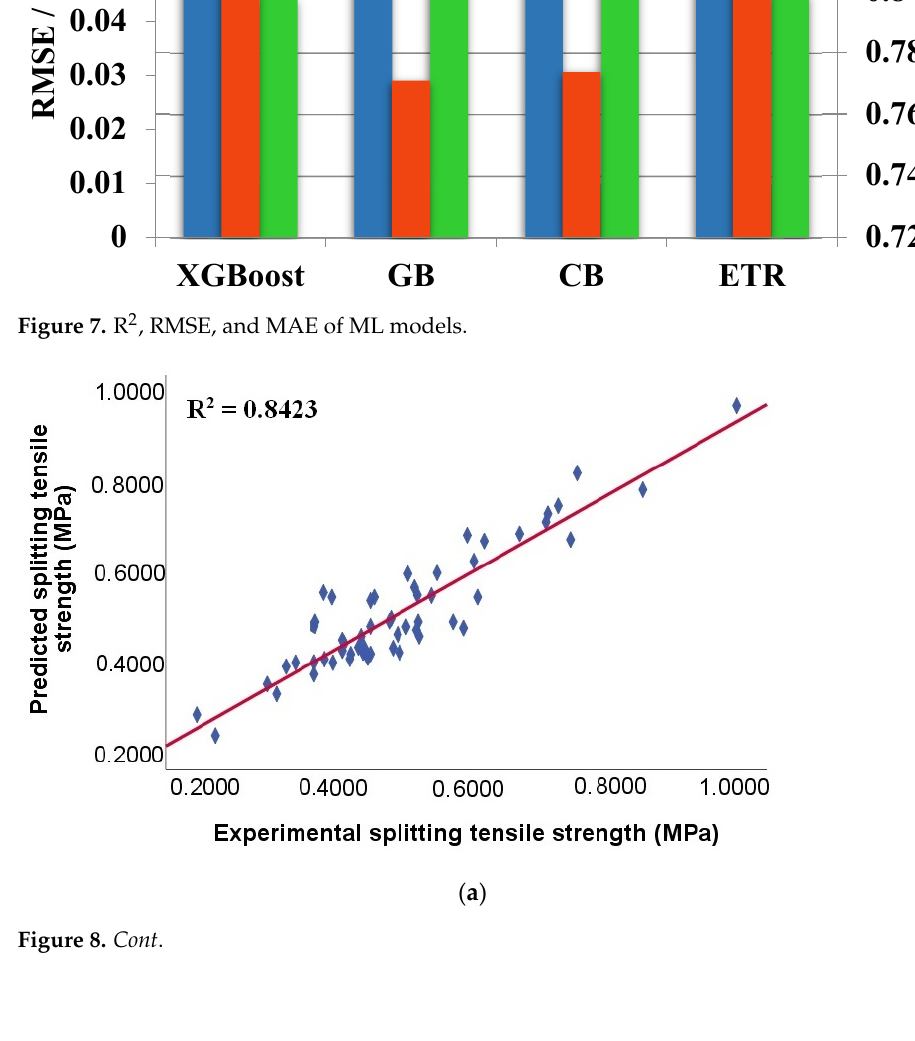
Figure 7. R 2 , RMSE, and MAE of ML models.